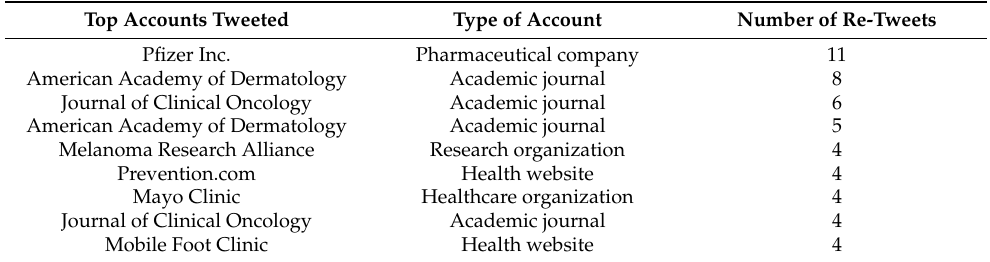
Table 3. The top-shared websites shared on Twitter as a source of melanoma-related information. Top Accounts